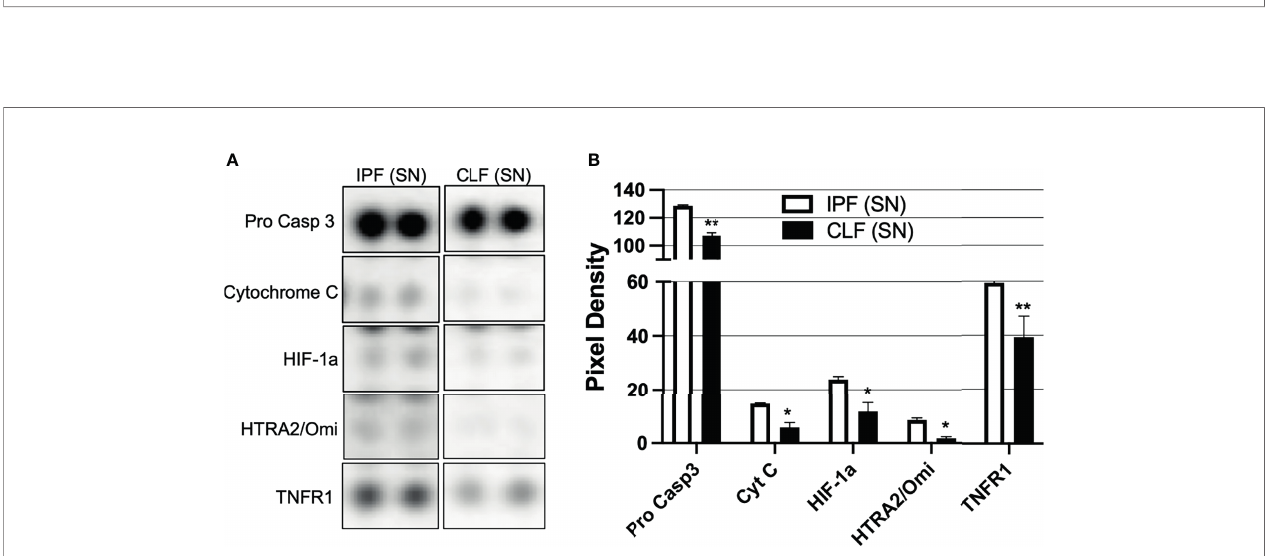
FIGURE 2 | The supernatant (SN) from IPF fi broblasts increases T-cell death at short-time exposure. T cells from fi ve healthy donors were cultured during 3 and 24 h with different IPF (SN) or control lung fi broblasts SN. T cells cultured with media were used as a negative control and those cultured with 1 m g/ml staurosporine (STU) were used as a positive control of apoptosis. (A) CD4+ T-cell and CD8+ T-cell gates were delimited, and cell death was analyzed in a dot plot color where Annexin-V+ cells indicated early apoptosis (E-Apop), Annexin-V+7-AAD+ late apoptosis (L-Apop), and 7-AAD+ necrotic cells (Nec). (B) Percentage of cell death evaluated at 3 h of culture. (C) Percentage of cell death evaluated at 24 h of culture. Bars indicate mean ± SD from the fi ve independent biological experiments. A multiple t -test and Holm – Sidak as post-test were used. * p < 0.05, ** p <